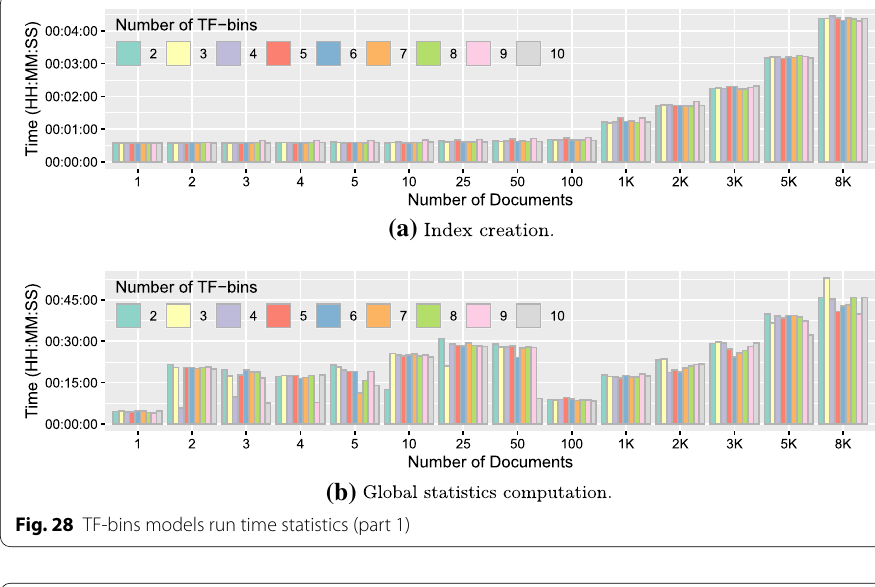
Fig. 28 TF-bins models run time statistics (part